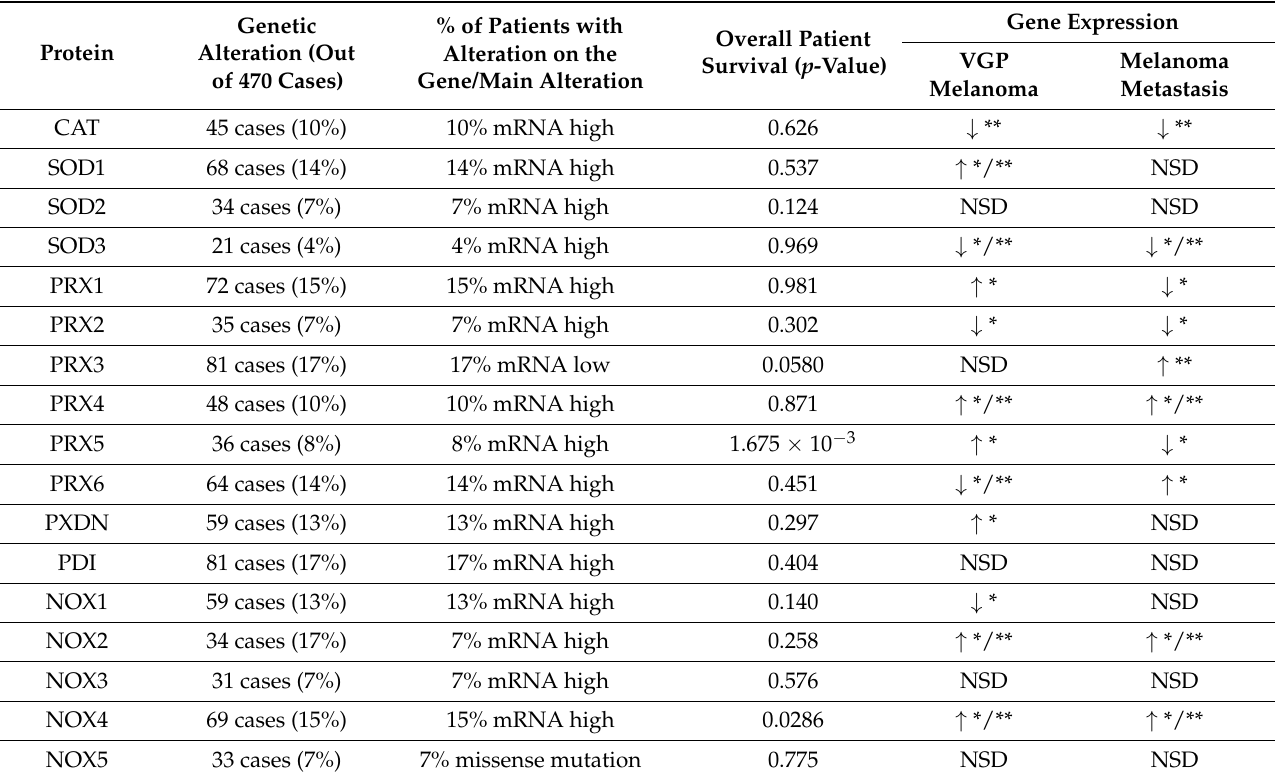
Table 2. Patient data about genetic alteration, survival status and gene expression of redox sensitive proteins in melanoma progression. * compared to common nevus/** compared to dysplastic nevus. NSD: no significant difference. NDF: no data